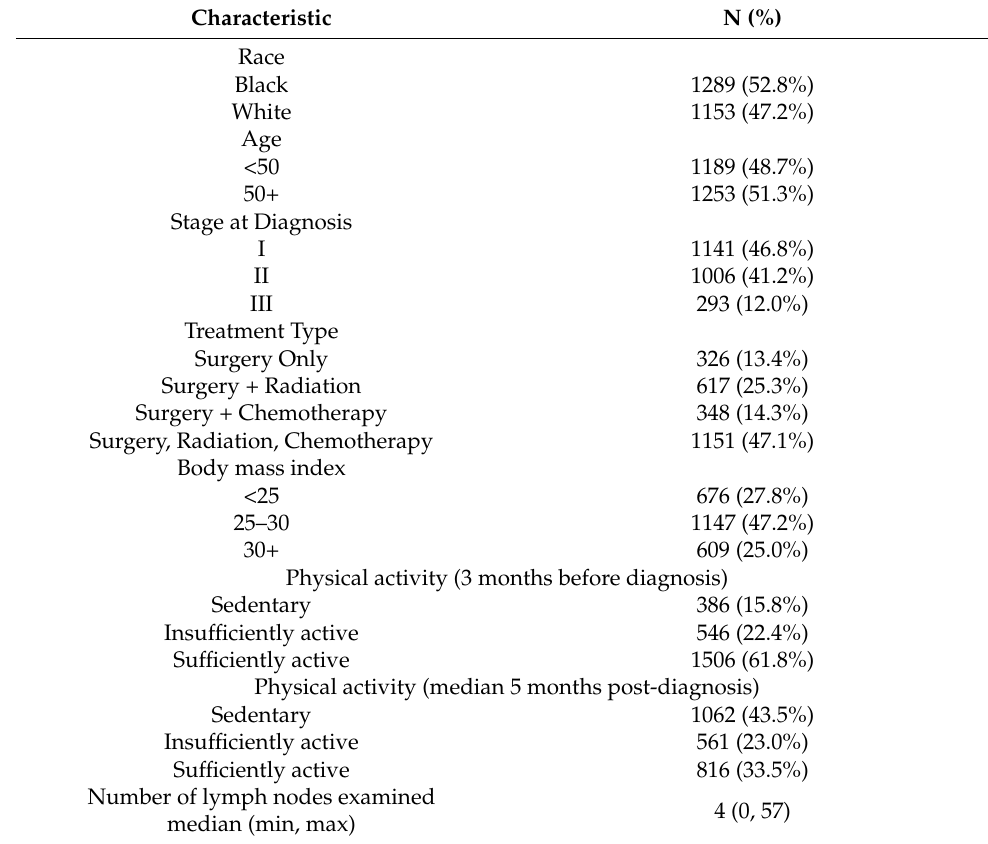
Table 1. Characteristics of the participants of the Carolina Breast Cancer Study, Phase